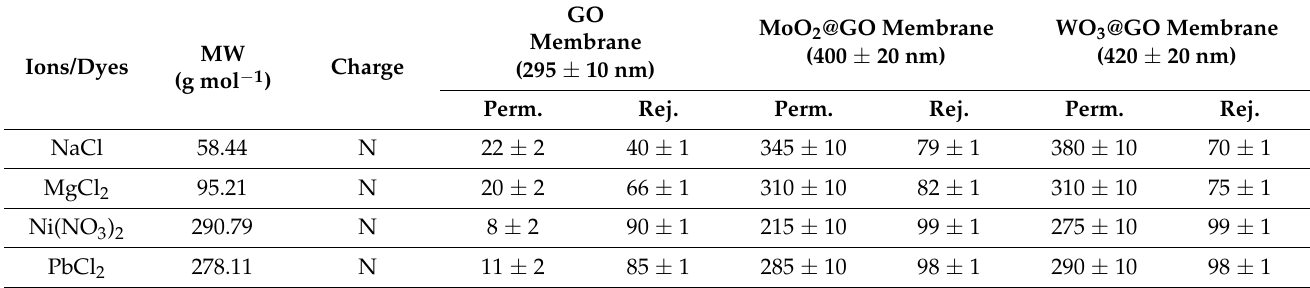
Figure 4. The salts separation performance of ( a ) MoO 2 @GO and ( b ) WO 3 @GO nanocomposite membranes, respectively, at transmembrane pressure of 1 bar. Table 2. Separation performance of the GO nanocomposite membranes for various salts at 25 ◦ C.